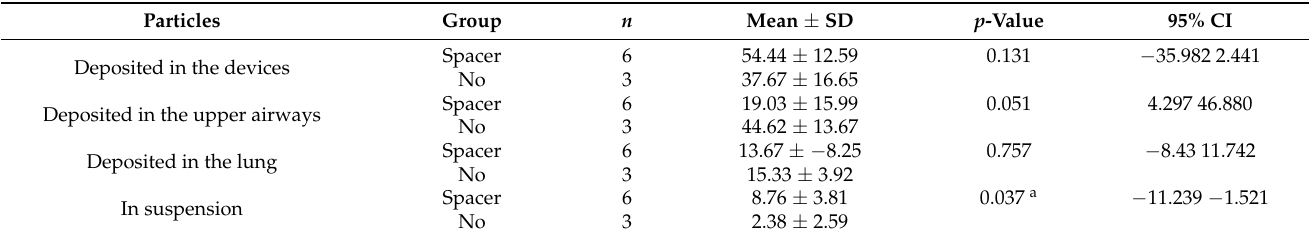
Table 6. Percentage of particle distribution and deposition when using or not a spacer.